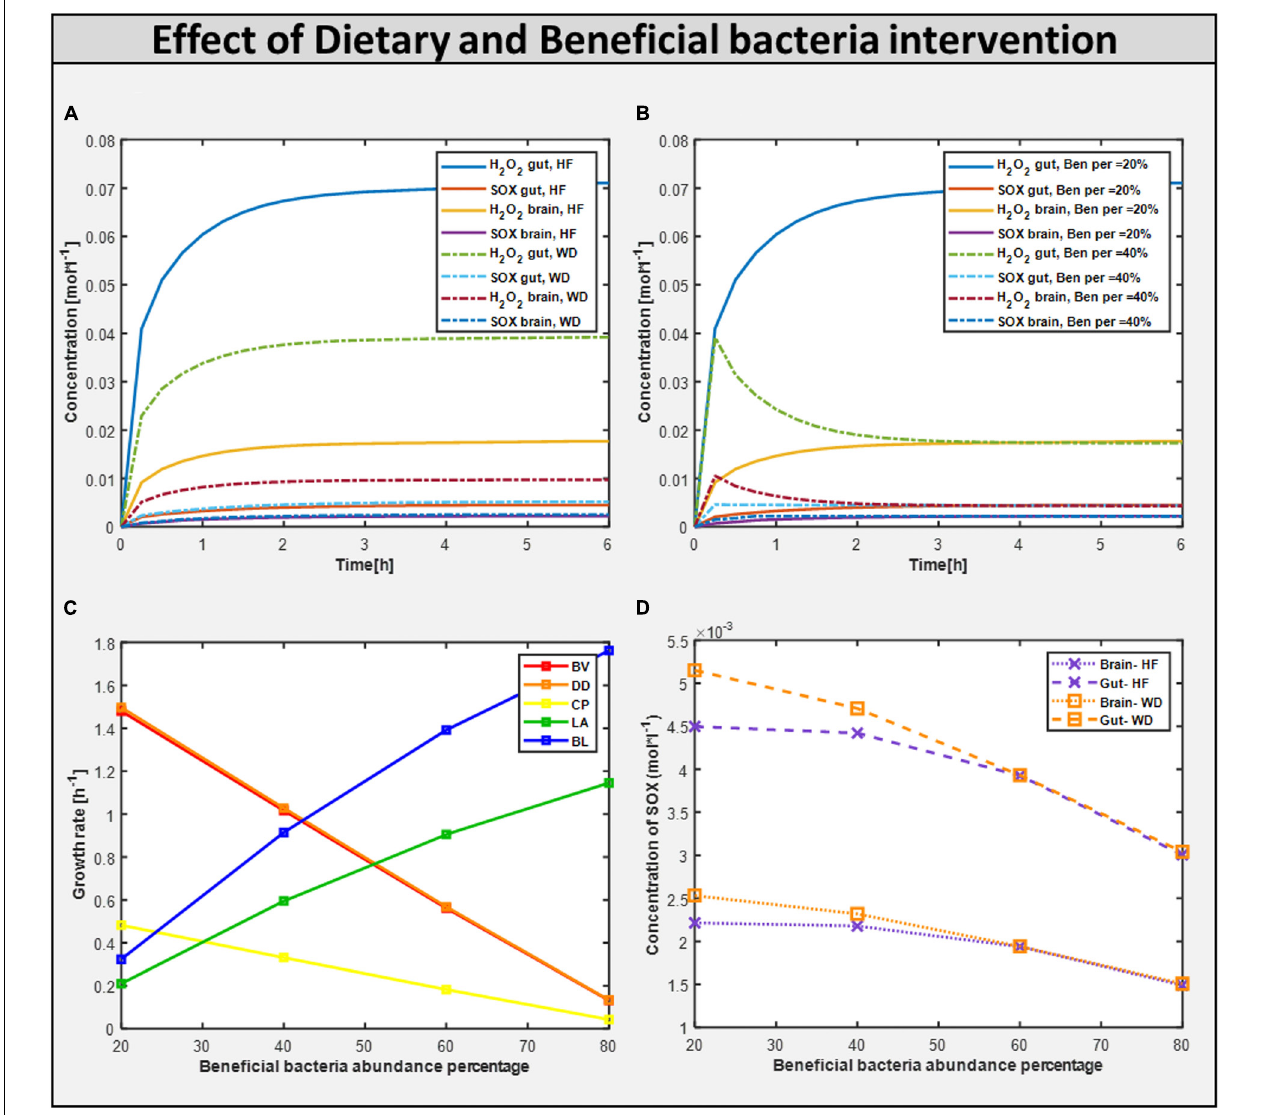
FIGURE 8 | Effect of dietary and probiotic intervention. (A) Toxins profile in 20% abundance of beneficial bacteria in the community with change in diet from HF to WD. (B) Toxins profile with varying beneficial bacteria abundance in the community from 20% to 40% with fixed diet HF. (C) Growth rate of different bacterial biomass at differential abundance percentage. (D) Reducing the build-up of ROS toxin i.e. Superoxide (SOX) with the help of increasing beneficial percentage along with the correct